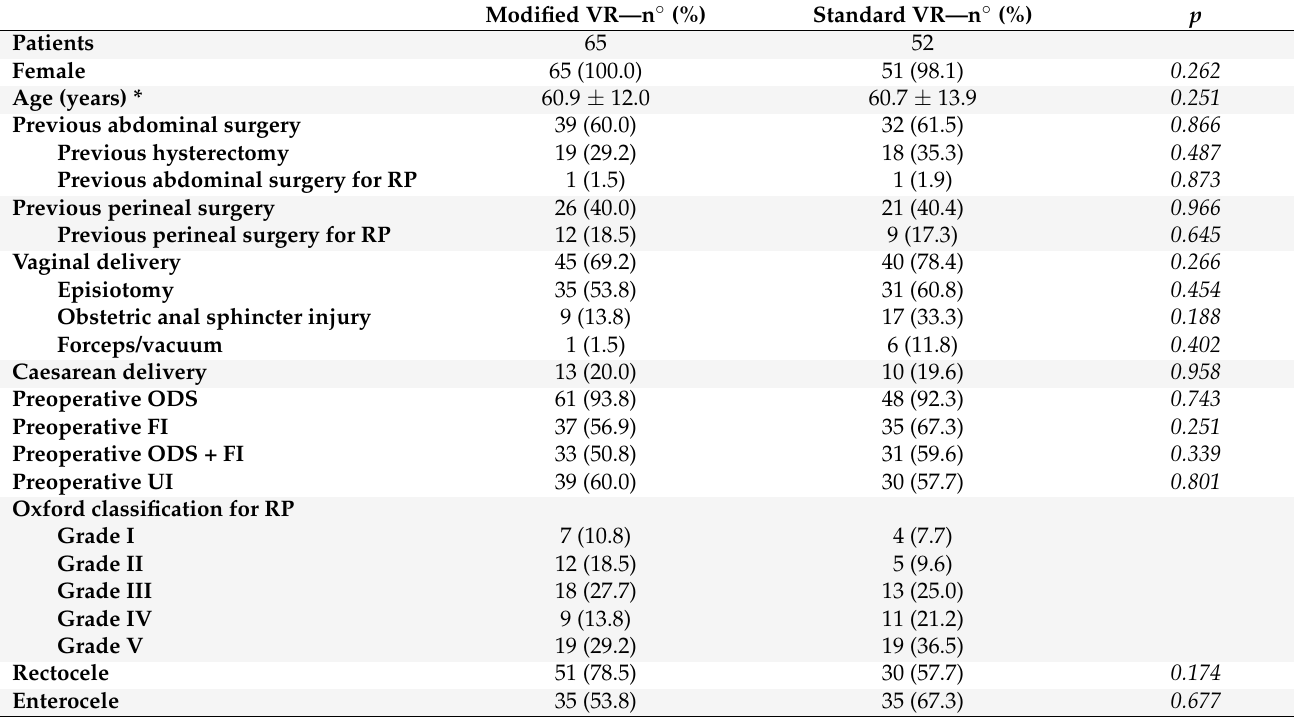
Table 1. Baseline characteristics of patients who underwent modified and standard ventral